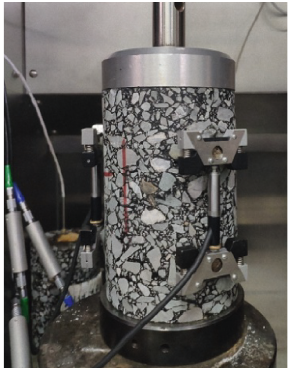
Figure 6: Photograph of a dynamic modulus sample (installed sensors).